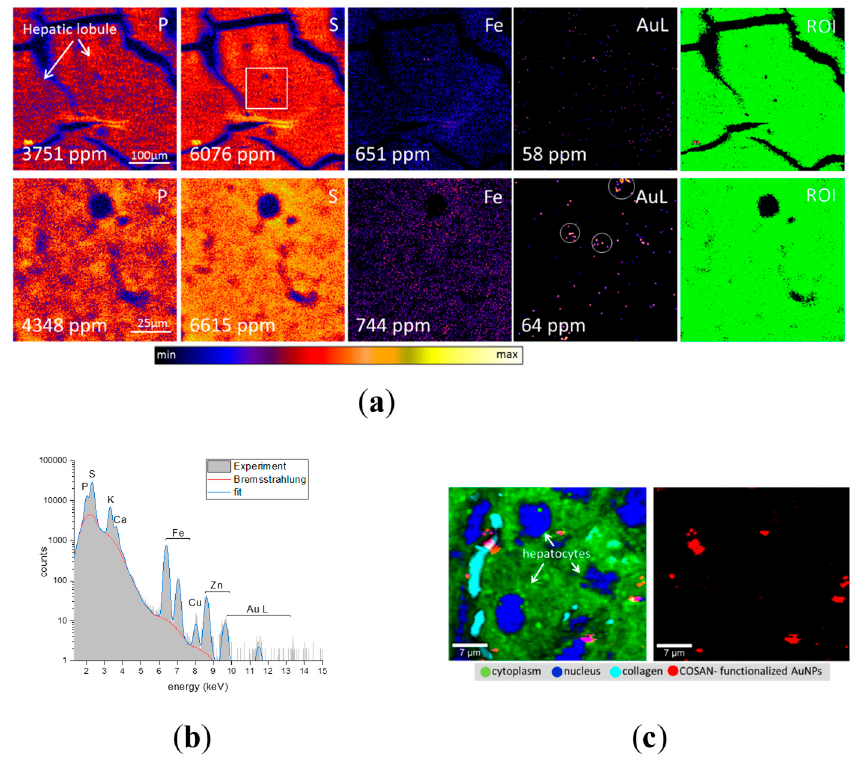
Figure 7. ( a ) µ PIXE images of intrinsic tissue elements (P, S, Fe) as well as Au in mouse liver at t = 72 h after intravenous administration of [ 124 I]PEG-AuNPs@[ 4 ] − . The area in the white rectangle was subsequently scanned with higher resolution. The concentration of elements was calculated from ROIs shown in green on the right side. White arrows denote hepatic lobules. White circles show small gold clusters; ( b ) PIXE spectrum extracted from ROIs; ( c ) CRM images of hepatocytes and distribution of [ 124 I]PEG-AuNPs@[ 4 ] − in in mouse liver at t = 72 h after intravenous administration of [ 124 I]PEG-AuNPs@[ 4 ] − . The color-coded image (left) shows the overlapping of nucleus, cytoplasm, collagen and COSAN- functionalized Au NPs.